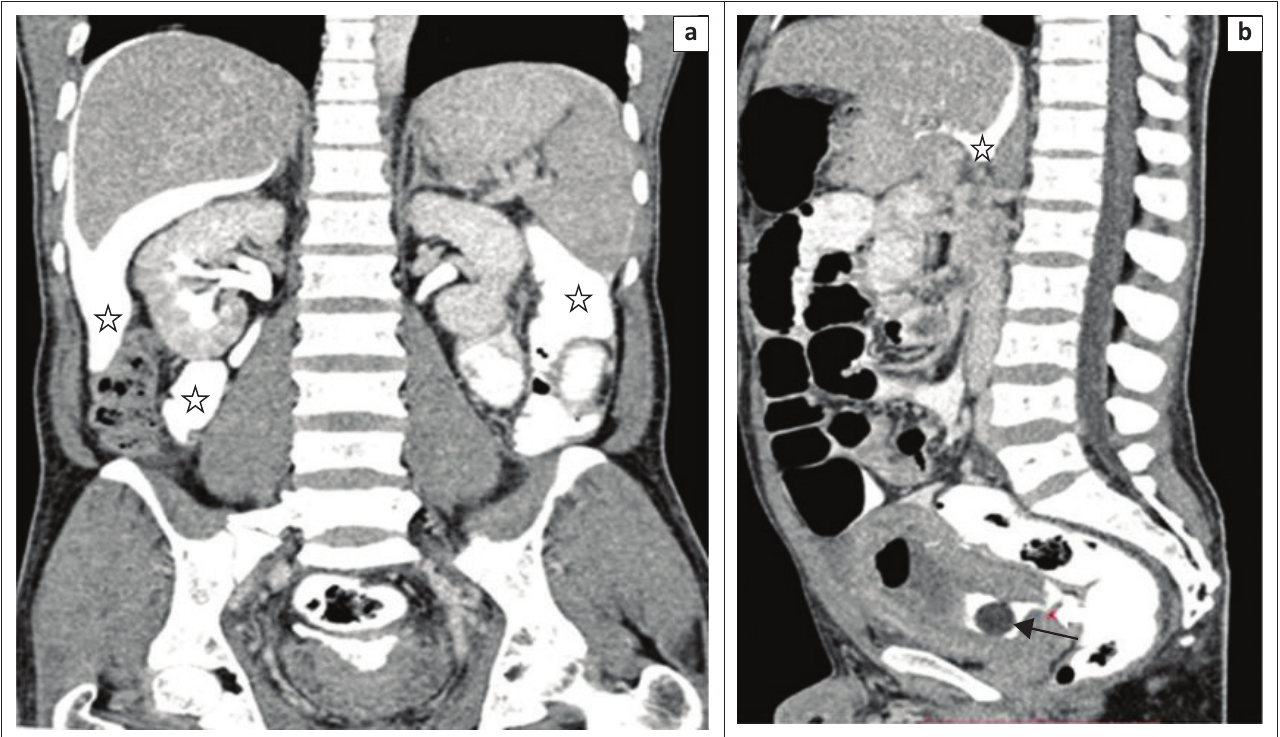
FIG URE 14: (a, b) Multidetector computed tomography coronal and sagittal reformatted images indicate rupture of the urinary bladder (arrow) with contrast material leaking into the peritoneal cavity, surrounding the bowel loops, along the paracolic gutters and reaching up to the subphrenic space (asterisks). The patient also had localised urethral injury (not shown in this image), for which he underwent MDCTU.